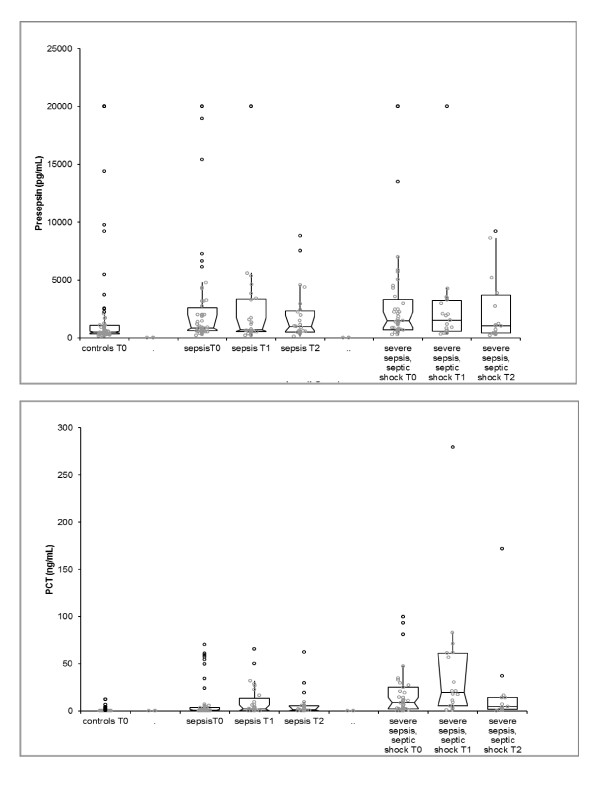
Median (boxplots) values of presepsin and procalcitonin in controls and in sepsis and severe sepsis/septic shock patient populations at time 0. 95% confidence intervals (CIs) are reported. Median (boxplots) seriated values of presepsin and procalcitonin (PCT) in 42 patients with sepsis and severe sepsis/septic shock at time 0 (T0), T1 and T2. 95% CIs are reported. Presepsin displayed highest concentration at T0 (P = 0.0444) compared to T1 and T2. The highest PCT levels were observed at T1 (P < 0.0001) compared to T0 and T2.{AU: Please define gray and black circles in figure legend. Gray circles represent values of presepsin or procalcitonin included between the min and the greatest value excluding outliers; black circles represent outliers. }